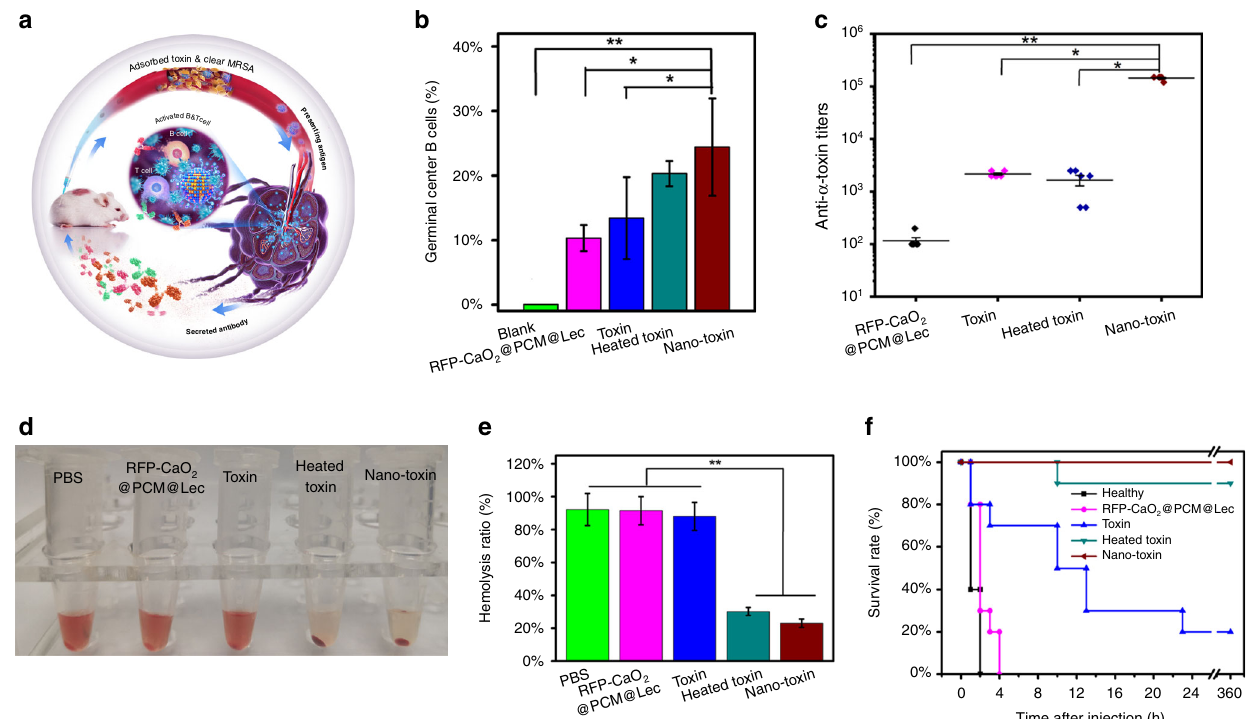
Fig. 6 Immune effect and in vivo toxin neutralization of nanoreactors. a The scheme demonstrating that nanoreactors stimulate the body ’ s immune response and improve the therapeutic effect of bacterially infected mice. b Flow cytometric analysis of cells in the draining lymph node at 21 days post administration with RFP-CaO 2 @PCM@Lec nanoreactors, toxin, heated toxin, or nano-toxin ( n = 3; mean ± SD). Cells were fi rst gated on the B220 + IgD low population and values are expressed as percentage GL-7 + . c Multivalent antibody responses in vivo. Mice were vaccinated with RFP-CaO 2 @PCM@Lec nanoreactors, toxin, heated toxin, or nano-toxin on day 0 with boosts on day 7 and 14. On day 21 post fi rst vaccination, the serum was sampled and analyzed for the presence of IgG antibody titers against toxin. d Representative images demonstrating the varying degrees of hemolysis. e Comparison of hemolysis induced by antibody generated by injection of PBS, RFP-CaO 2 @PCM@Lec nanoreactors, toxin, heated toxin and nano-toxin ( n = 3; mean ± SD). f Survival rates of mice over 15 days following an intravenous injection of α -toxin (120 μ g kg − 1 ). The mean value was calculated by the t test (mean ± SD). * p < 0.05, ** p < 0.01, *** p < 0.001, compared with the indicated group. Source data are provided as a Source Data fi